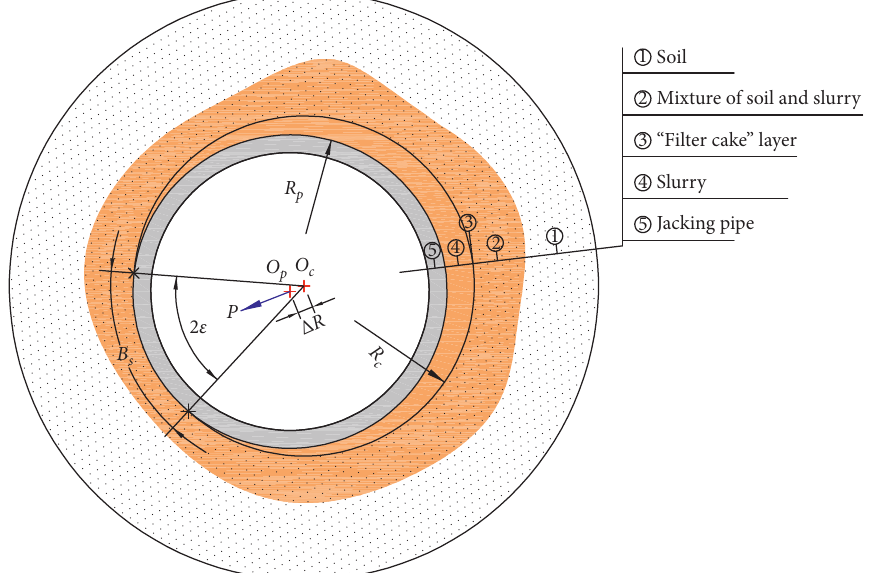
Figure 4: Contact model and symbols